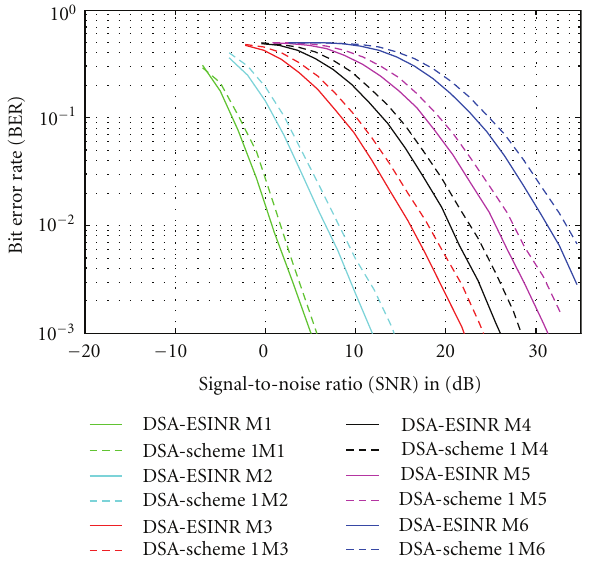
Figure 11: BER comparison between DSA-SINR and DSA-Scheme 1 in “Default” uncorrelated channel.